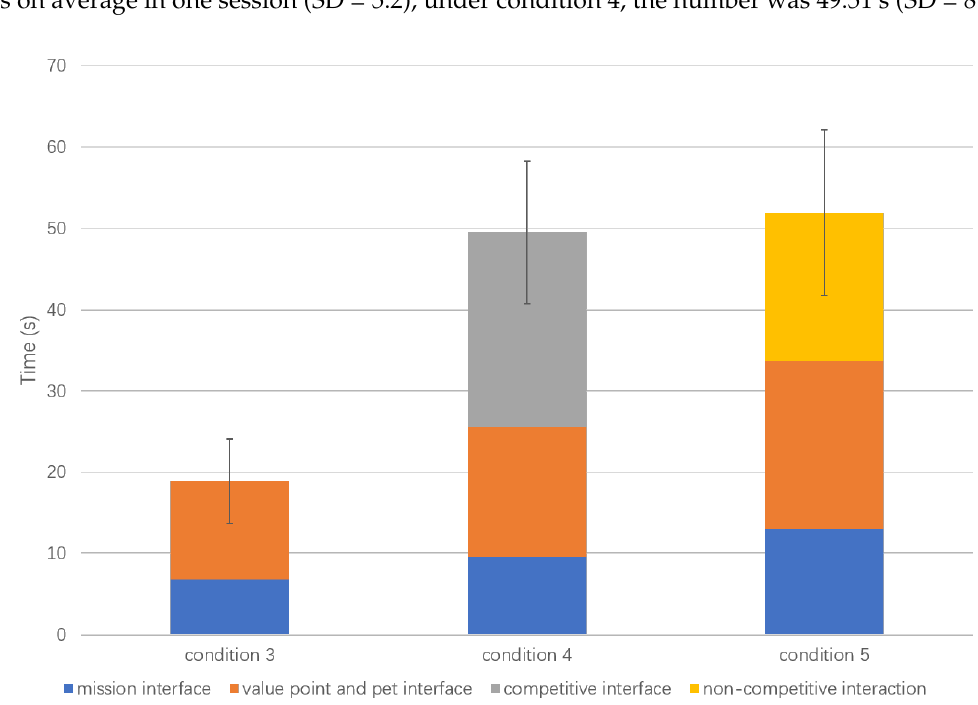
Figure 10. Average usage time of each interface per person per